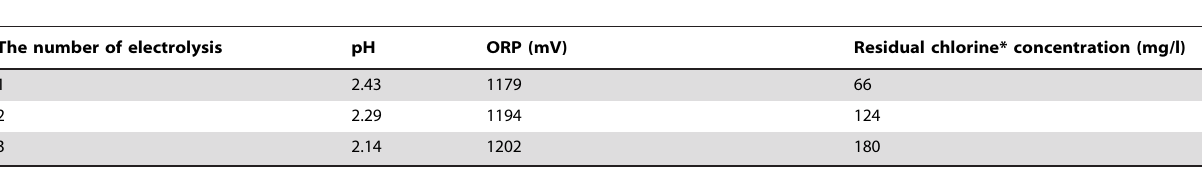
Each value represents the mean of duplicate determinations. *Residual chlorine is consisted of combined available chlorine and free available